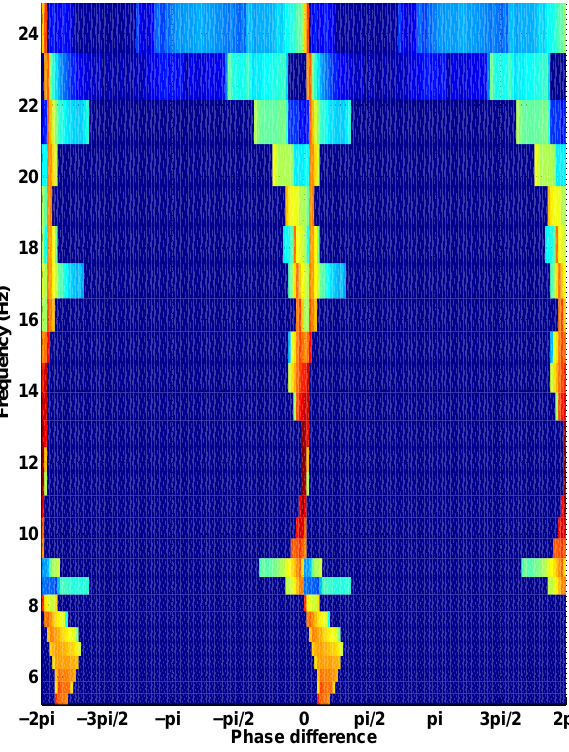
Fig. 4. The ω − k joint spectrum calculated from the phase differ- ences measured between the two parallel electric field components E 13 and E 42 for event